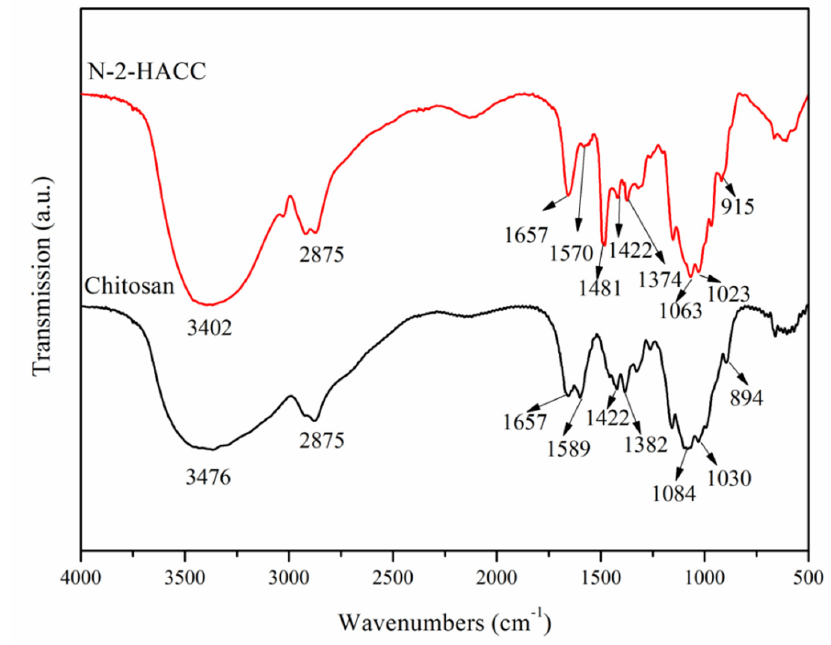
Figure 2. FTIR spectra of CS and N-2-HACC.